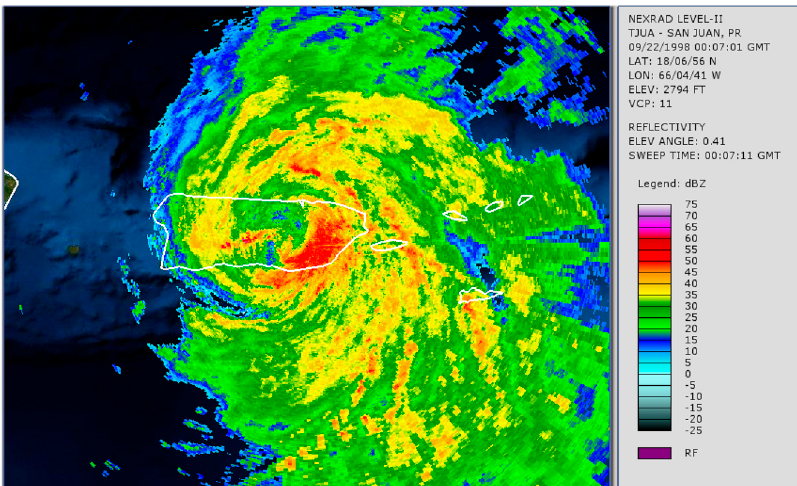
Figure 3. Reflectivity over Puerto Rico during Hurricane Georges, 22 September 1998 00:07:01 UTC. Puerto Rico and the neighboring islands are shown in white lines. The lowest reflectivity is represented with the blue tonality and the highest reflectivity is represented with the red tonality. The reflectivity patterns were obtained from the WSR-88D radar located in Cayey, Puerto Rico [18].